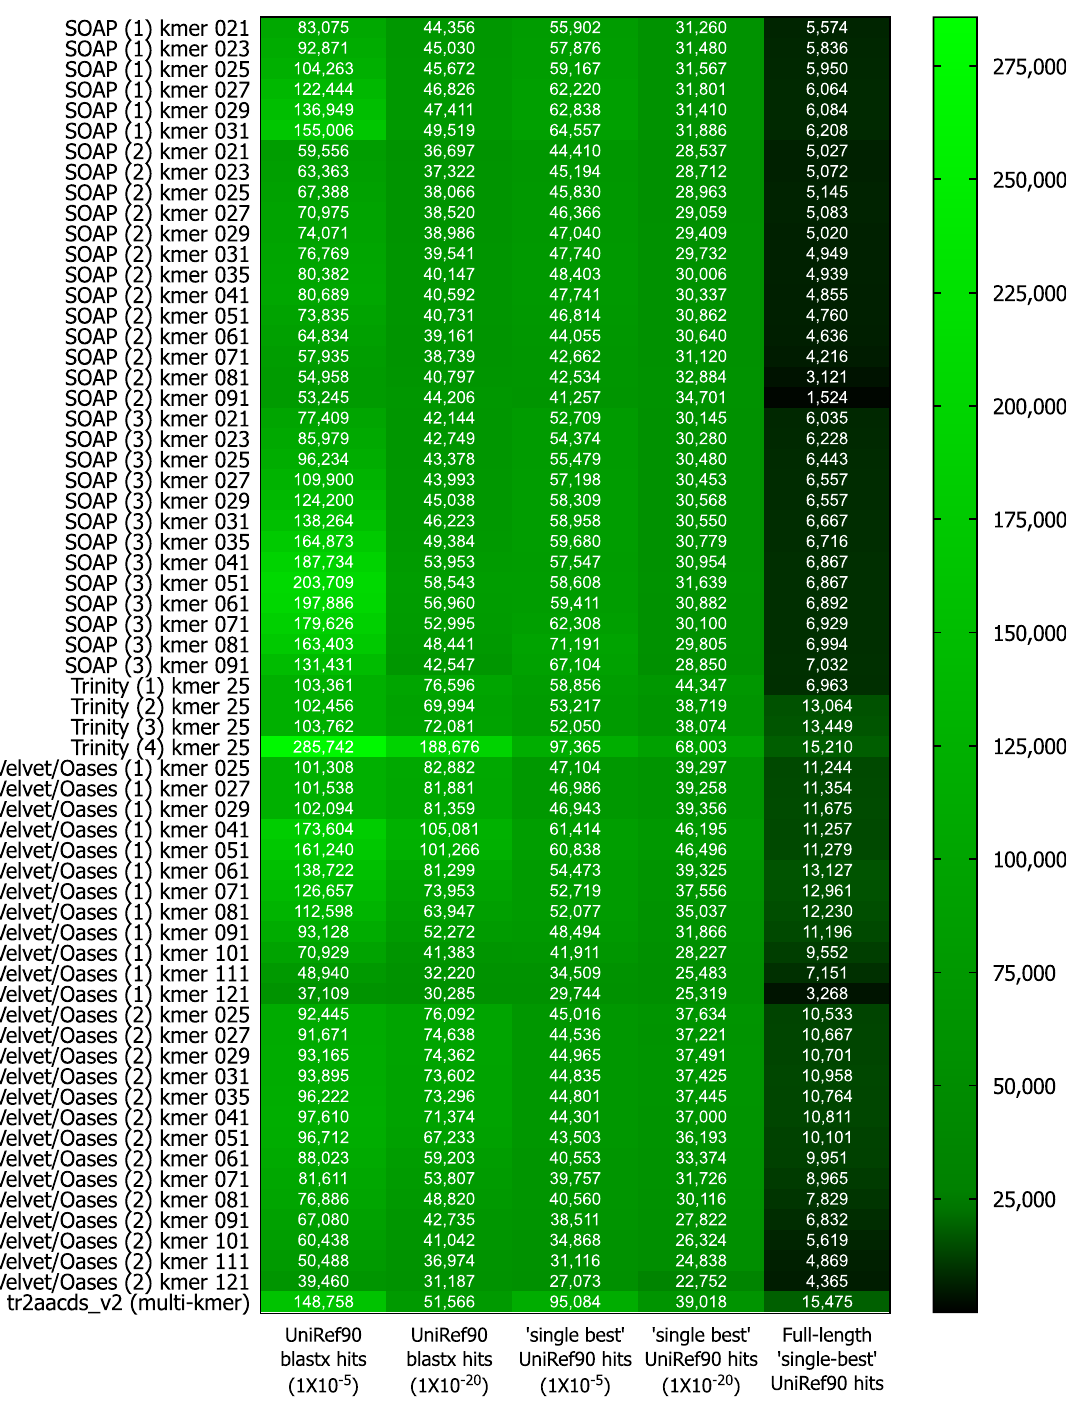
Figure 11. Diamond BLASTx hits from the UniRef90 database. SOAPdenovo-Trans (1): no filtering; (2): light filtering of poor quality read pairs, combined with in silico normalization; (3): moderate filtering of poor quality read pairs; Trinity (1): light filtering of poor quality read pairs, combined with in silico normalization; (2): moderate filtering of poor quality read pairs; (3): light filtering of poor quality read pairs, combined with SEECER error correction; (4) Trinity v2.3.2 after moderate filtering of poor quality read pairs; Velvet/Oases (1): moderate filtering of poor quality read pairs; Velvet/Oases (2): moderate filtering of poor quality read pairs combined with in silico